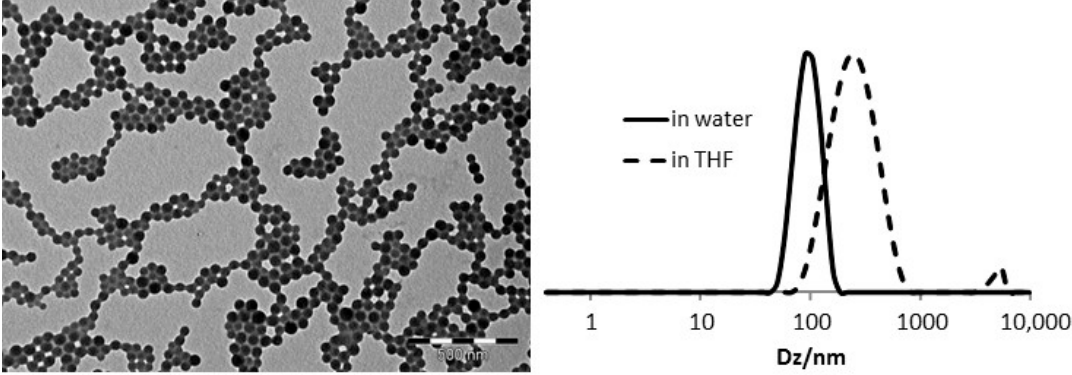
Figure 4. TEM image ( left ) and DLS response in water and THF solutions ( right ) for BMOPP@NG.